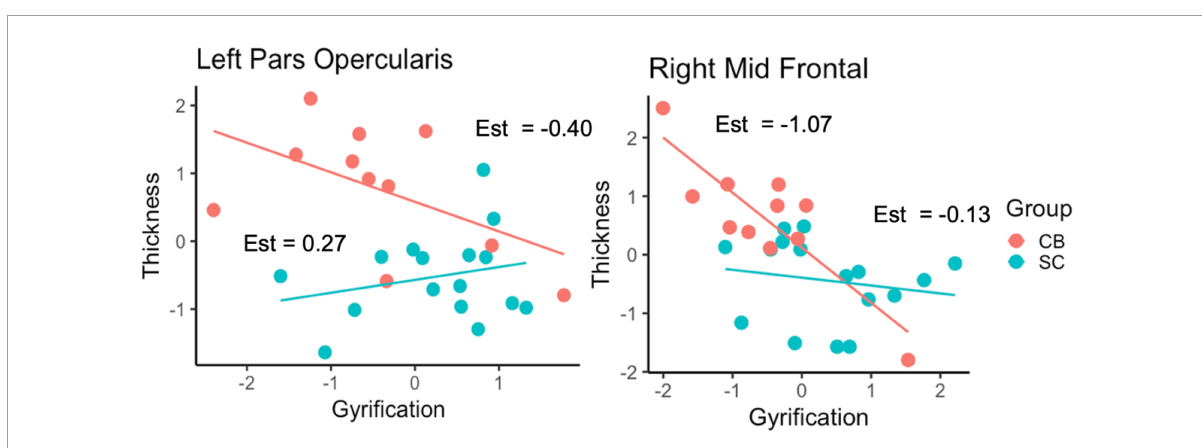
FIGURE2 Relationship between GY and CT as a function of Group for the left pars opercularis and right rostral middle frontal cortex. Est = estimates of individual